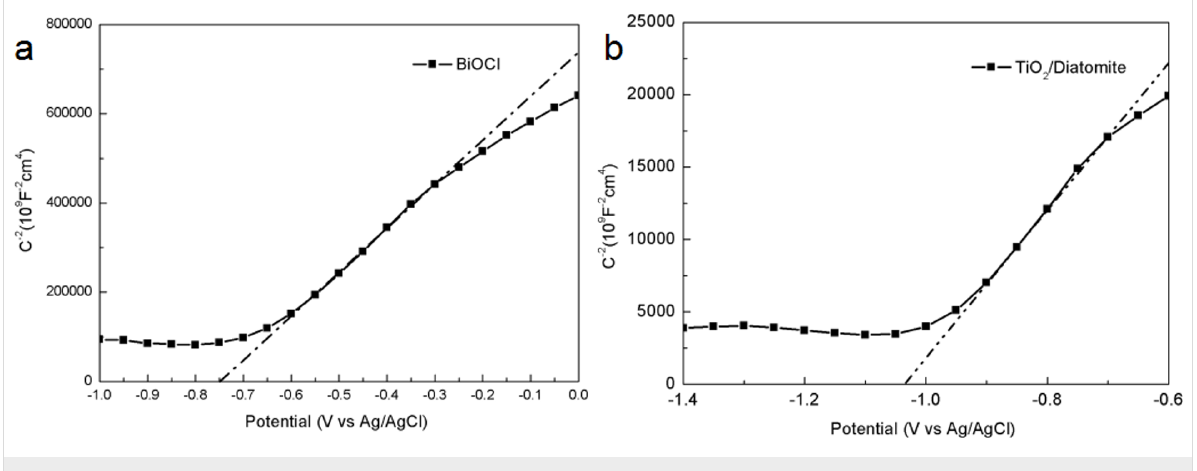
Figure 9: Mott–Schottky plots of BiOCl (a) and TiO 2 /diatomite (b).